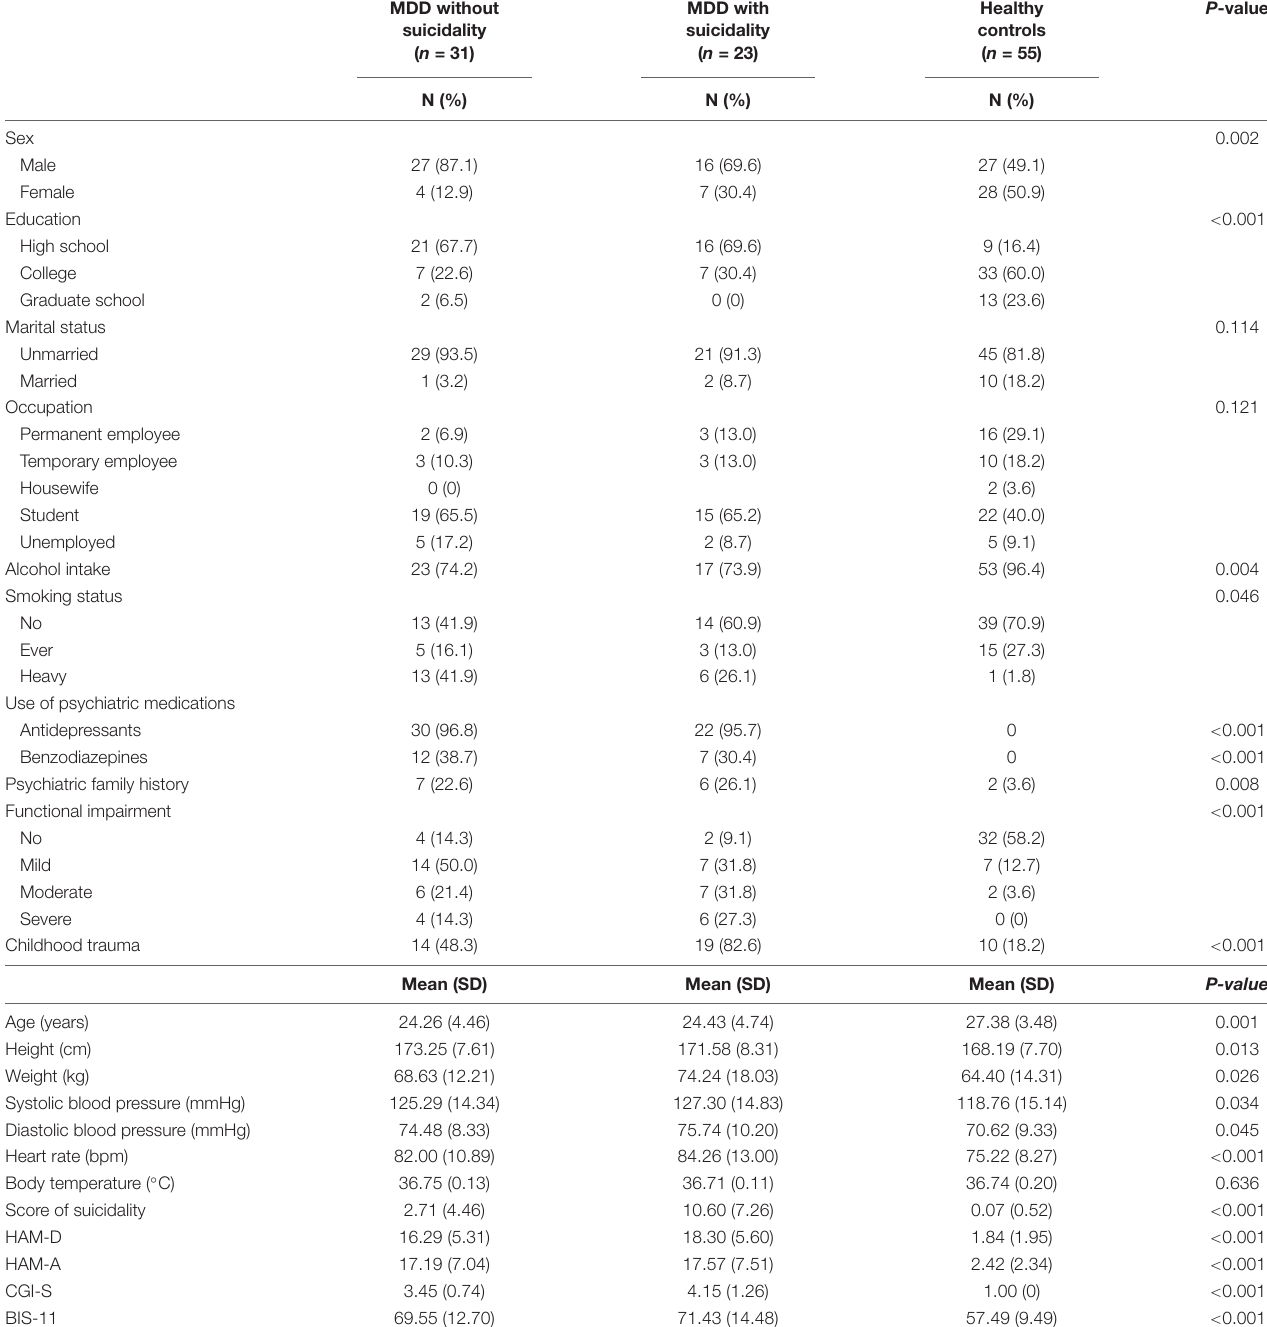
TABLE 1 | Baseline characteristics of